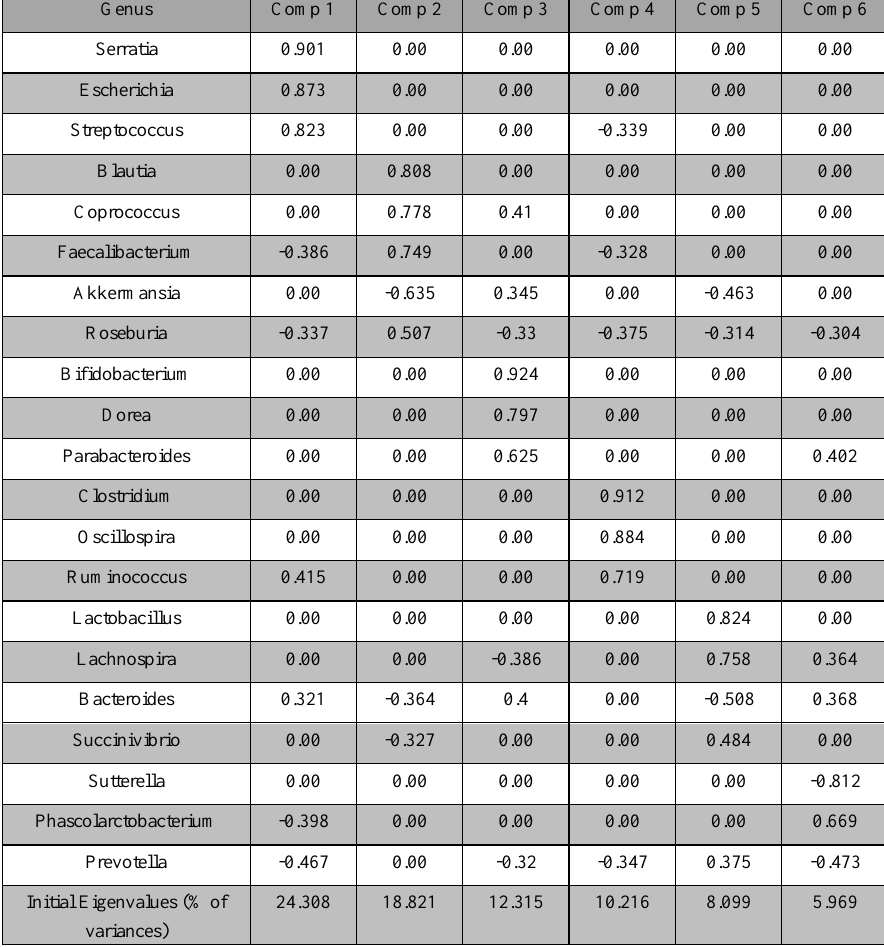
Table 2a. A rotated Component matrix for Genus among T2DM subjects.